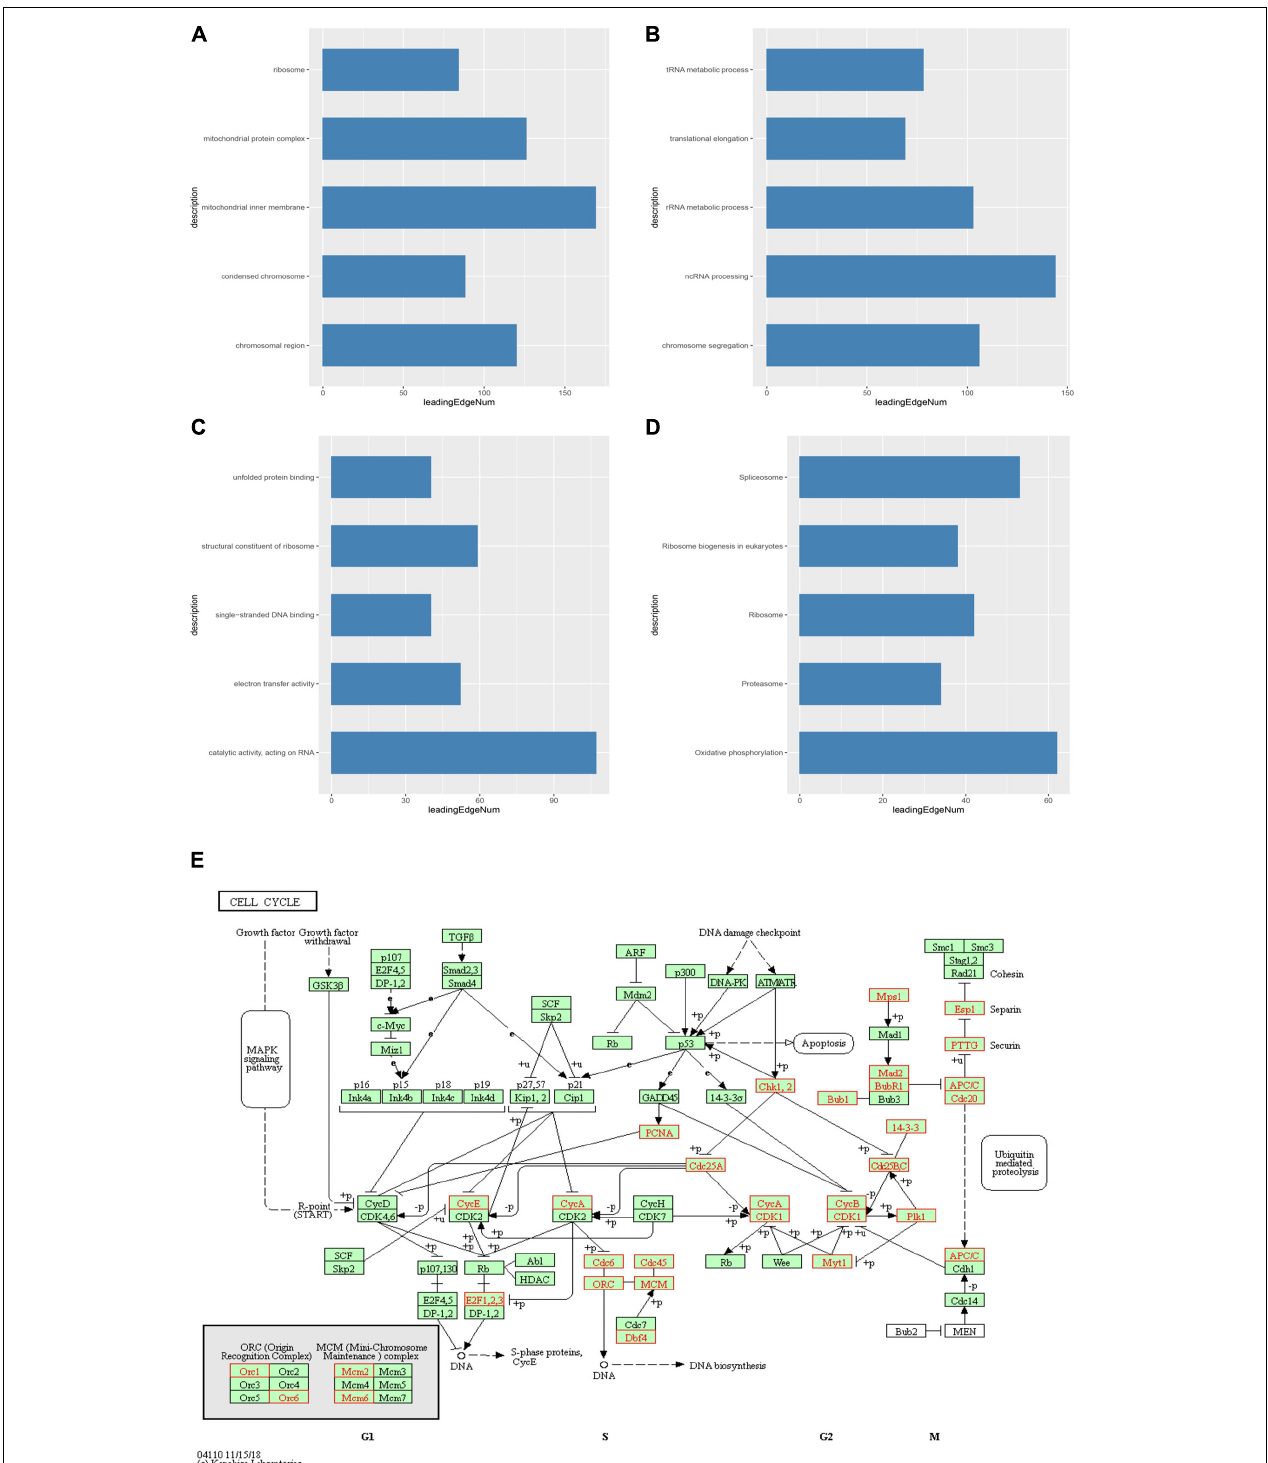
FIGURE 7 | Significantly enriched GO annotations and KEGG pathways of TIMM17A network genes in breast carcinoma. GO annotations and KEGG pathways of genes with expression levels associated with TIMM17A expression in BRCA analyzed using GSEA. (A) Cellular components. (B) Biological processes. (C) Molecular functions. (D) KEGG pathway analysis. The blue column represents –log10(p). (E) KEGG pathway annotations of the cell cycle pathway. Red marked nodes are associated with the LeadingEdgeGene.